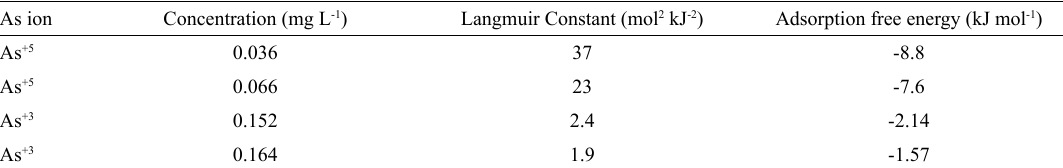
Table 9: Gibbs free energy for As ions (As +5 y As +3 ) at different experimental conditions, calculate from the Langmuir model As